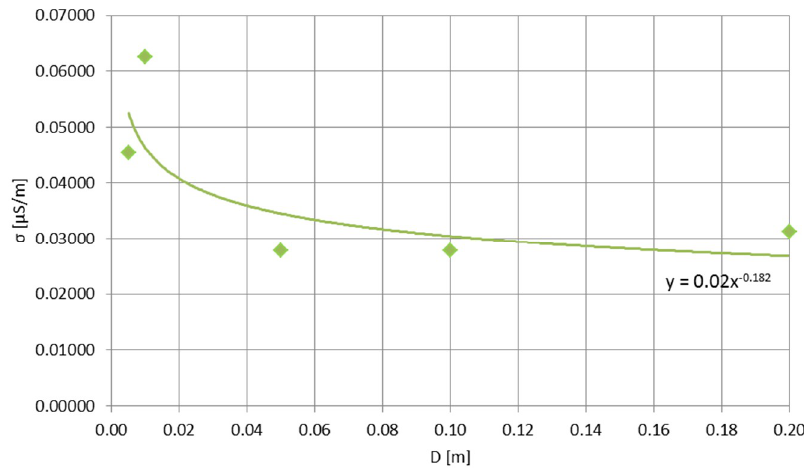
Figure 8. The resistance of the Glacier Paradise ice measured with increasing distance between the probes.